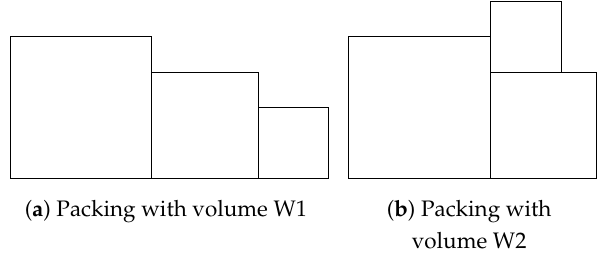
Figure 1. Two cases of packing three cubes.